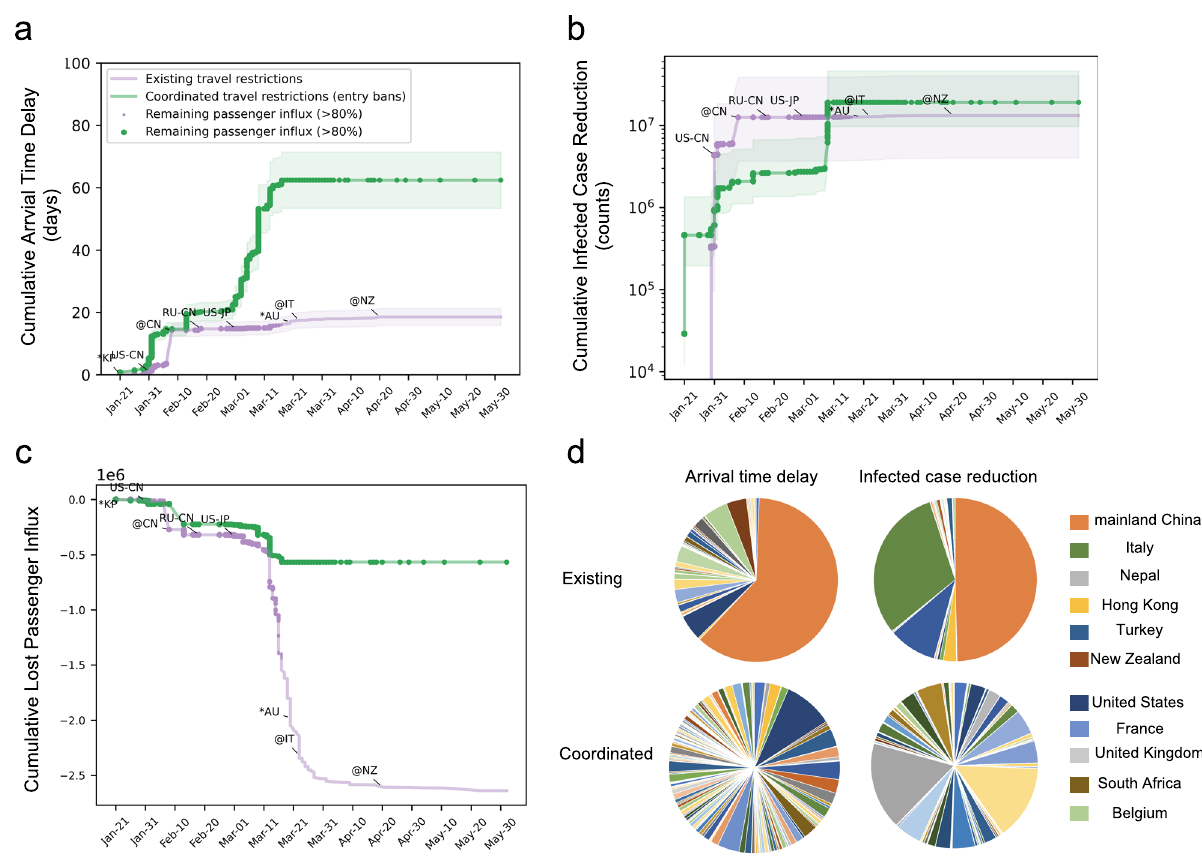
Fig. 7 Comparison between optimized travel restrictions deployed in a coordinated approach and existing travel restrictions. The comparisons are performed for arrival time delay ( a ), infected case reduction ( b ), and lost passenger in fl ux ( c ). The shaded areas in a , b present the 95% con fi dence intervals for the estimated value according to the speeds of arrival times/infected cases (Fig. 2e, f). d Pie charts illustrate the comparisons of the proportion of geographical areas ’ contributions to inducing arrival time delays and infected case reductions. Each solution of optimized travel restriction, which comprises a set of coordinated entry bans, is the non-dominated solution determined using the non-dominated sorting genetic algorithm II. The markers for travel restrictions a – c are the same as in Fig. 3 and the two-letter codes for geographical areas can be found in Supplementary Table